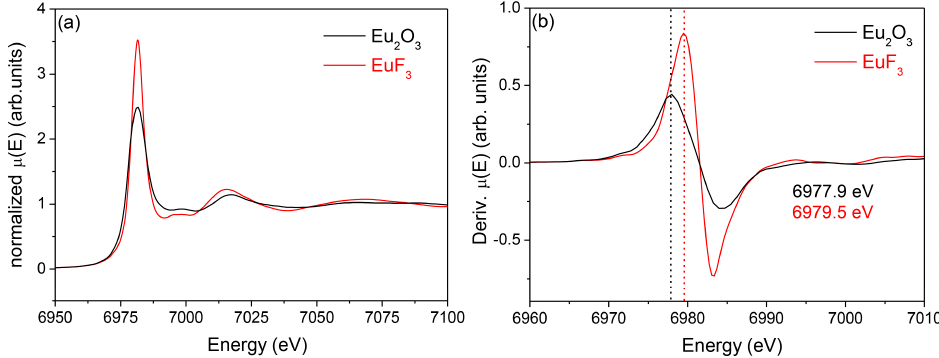
Figure 19. XAS ( a ) spectra and ( b ) derivate of Eu 2 O 3 and EuF 3 reference samples. The values shown in ( b ) refer to the maximum of the derivate curves.